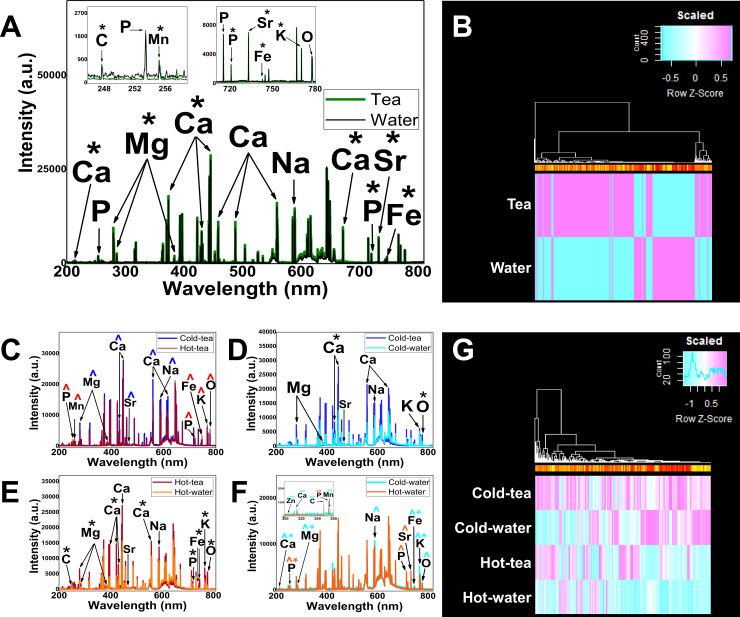
LIBS demonstrates changes in enamel composition.(A) The comparison of emission lines from in vivo teeth treated with tea (green lines) and water (black lines). The insert shows the range of wavelengths (200–260 nm, and 700–780 nm) displaying the specific element peaks from in vivo groups. (B) Heat map visualization comparing in vivo tea vs in vivo water. (C) Comparison between in vitro groups, Cold-tea (blue lines) vs hot-tea (red lines) showing the elemental intensity variation. (D) Cold-tea (dark blue lines) vs cold-water (light blue lines) comparison showing a significant increase in Ca and O lines from cold-tea group. (E) Hot-tea (red lines) vs hot-water (orange lines) showing a significant increase in the elements from hot-tea. (F) Hot-water (orange lines) vs cold-water (light blue lines) showing a significant increase in the elements from both groups. Insert shows the range of wavelengths (200–260 nm) displaying the specific element peaks from control hot and cold water. Statistically significant increases are represented by *. The major intensities are represented by ^’s colored coded the same as the group color line. (G) Heat map visualization for in vitro groups. For both heatmaps the color is a representation of the difference in intensity between groups. Heat map is a representation of difference where 0 is zero difference, scaled from -1 to 1 representing the range of differences. The color is a representation of change difference. The clustering is based on likeness for the different peaks from the wavelengths.